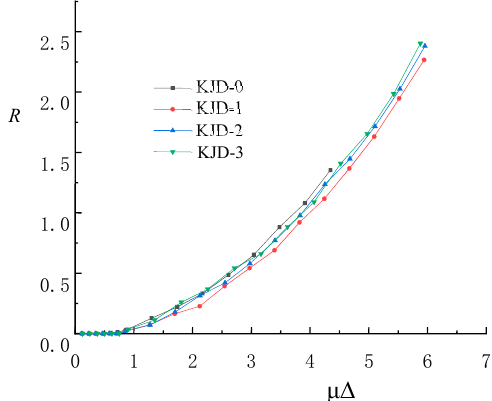
Figure 17. Residual displacement coefficient curves.